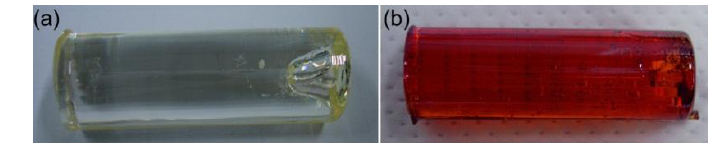
-20PbO-20PbCl 2 2